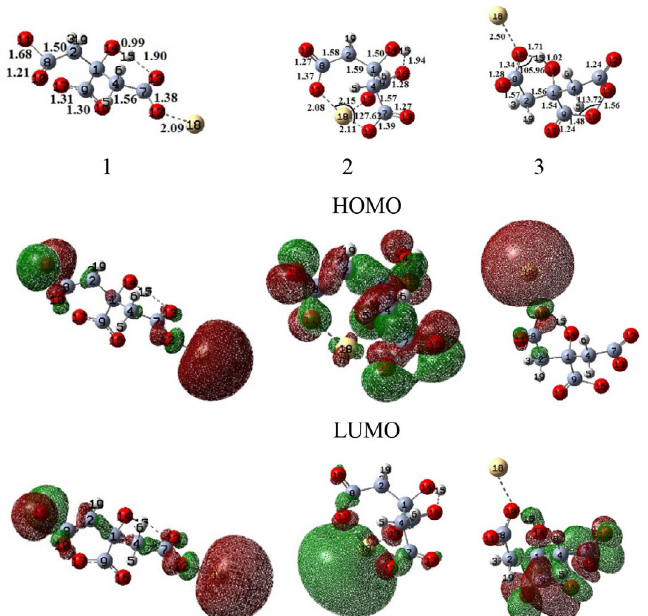
Figure 2. Selected geometrical parameters of the systems citrate ion-Cd whereby bond lengths are in angstroms (Å) and angles in °. HOMO and LUMO surfaces are depicted for all the